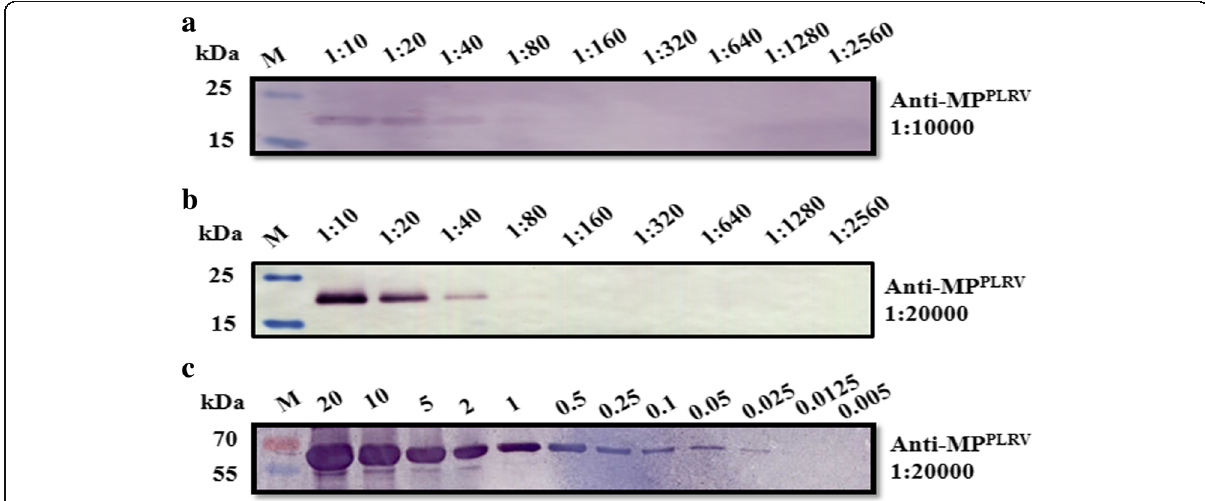
Fig. 3 Sensitivity analysis of PLRV-MP antiserum by Western blotting. a , b Lane M: PageRuler Prestained Protein Ladder, and the rest of the lanes show multiple dilutions of stock protein from the PLRV-infected Nicotiana benthamiana leaves (10-, 20-, 40-, 80-, 160-, 320-, 640-, 1280-, and 2560- fold), with anti-MP PLRV at the ratio of 1:10000 and 1:20000 respectively. c Lane M: PageRuler Prestained Protein Ladder, and the rest of the lanes show different concentrations of purified MP fusion protein (20, 10, 5, 2, 1, 0.5, 0.25, 0.1, 0.05, 0.025, 0.0125, and 0.005 ng), with antiserum at the ratio of